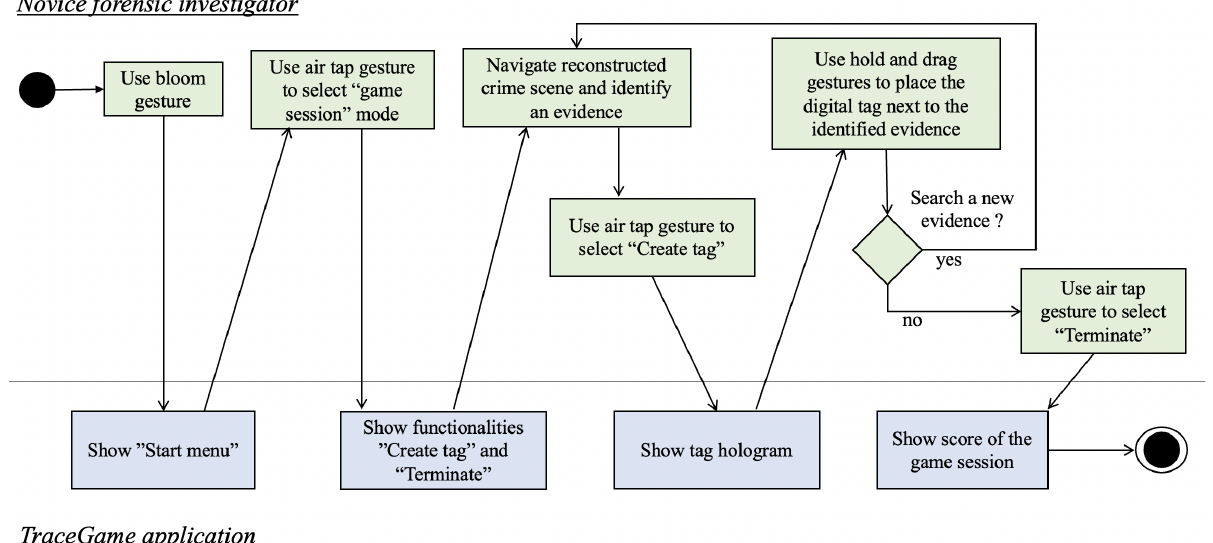
Figure 6. Activity diagram for the game session user mode in